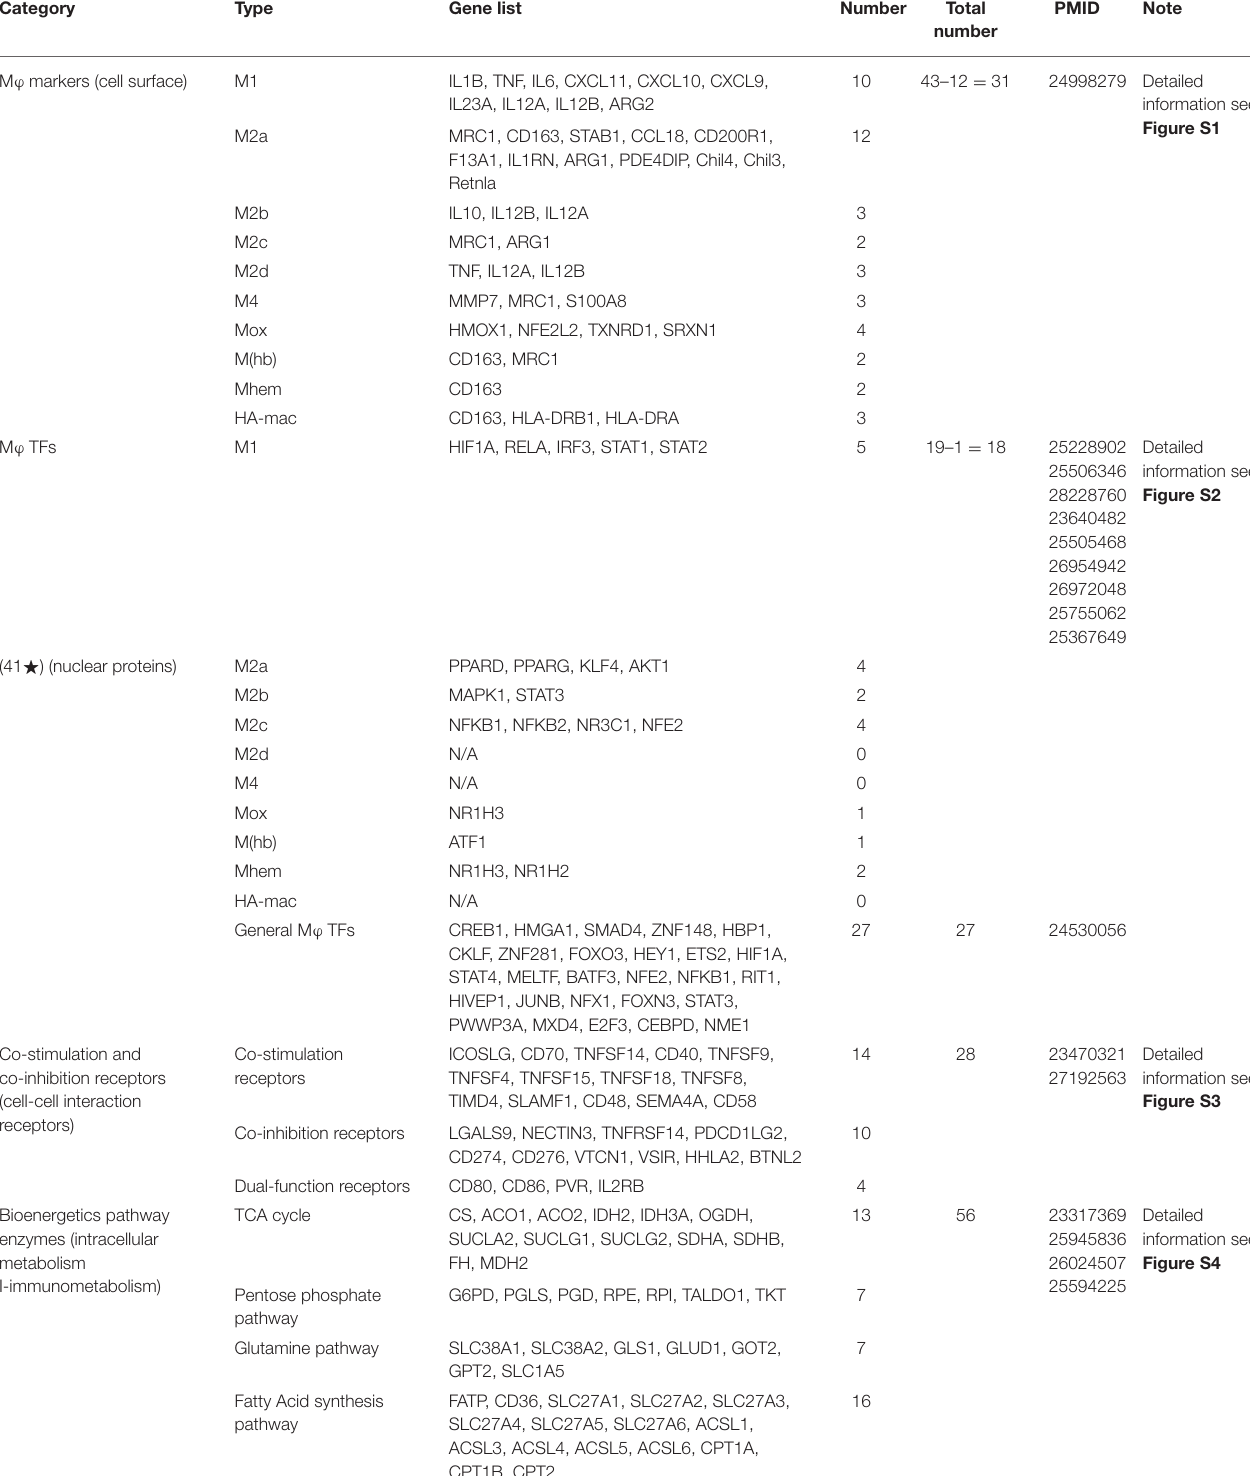
TABLE 2 | A total of 207 macrophage (M ϕ )-related regulator genes in seven representative groups were studied in this paper, including 31 M ϕ subset marker genes, 18 M ϕ subset transcription factor genes (TF), 27 M ϕ general transcription factor genes, 28T cell co-stimulation and co-inhibition receptor genes, 56 bioenergetics pathway enzyme genes, 23 trained immunity (innate immune memory) pathway genes, and 24 exosome biogenesis/docking mediator